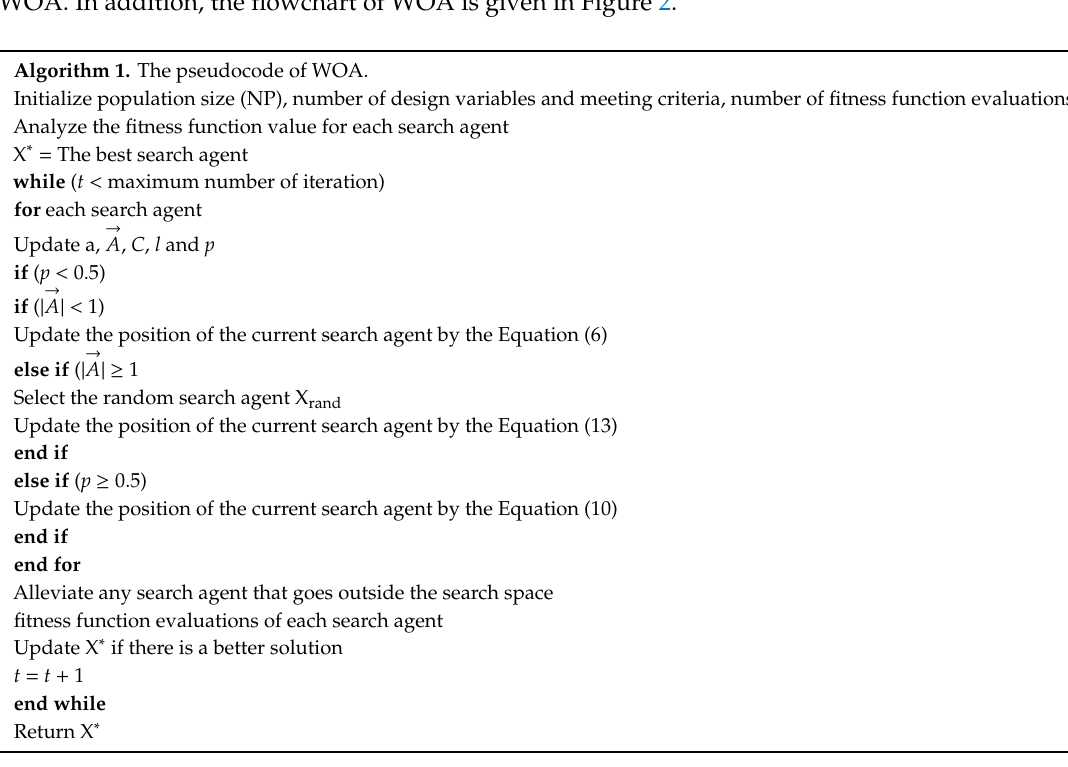
Algorithm 1. The pseudocode of